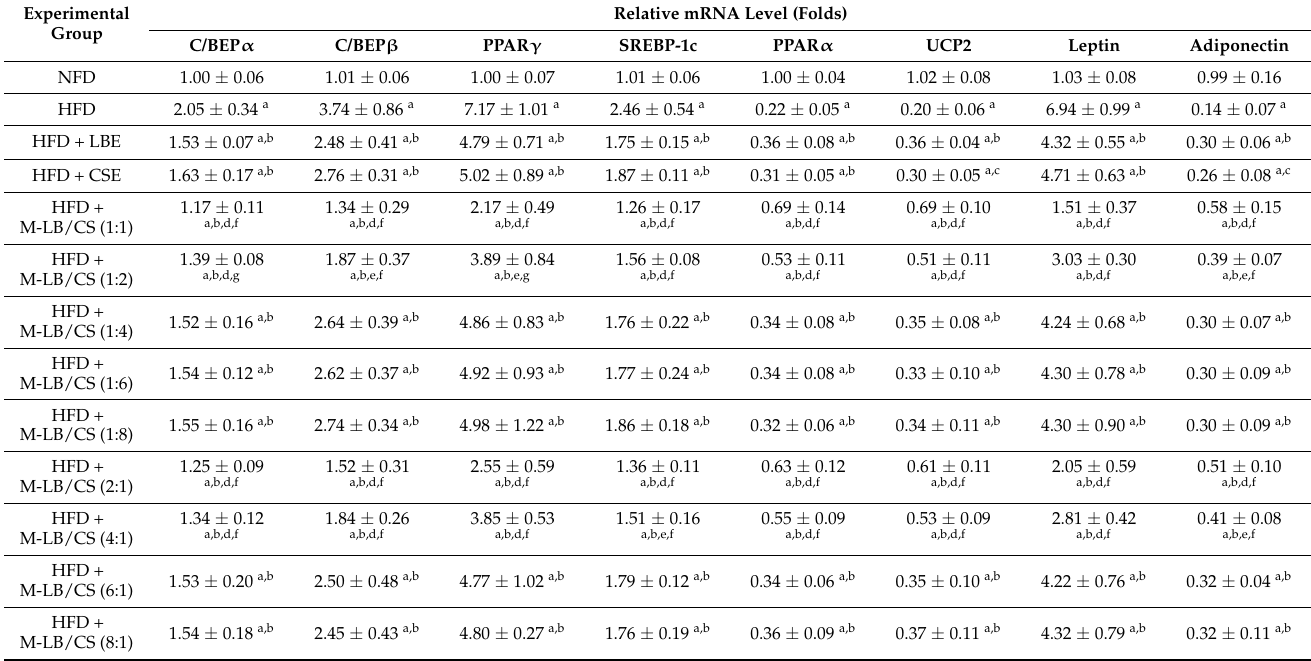
Relative mRNA Level